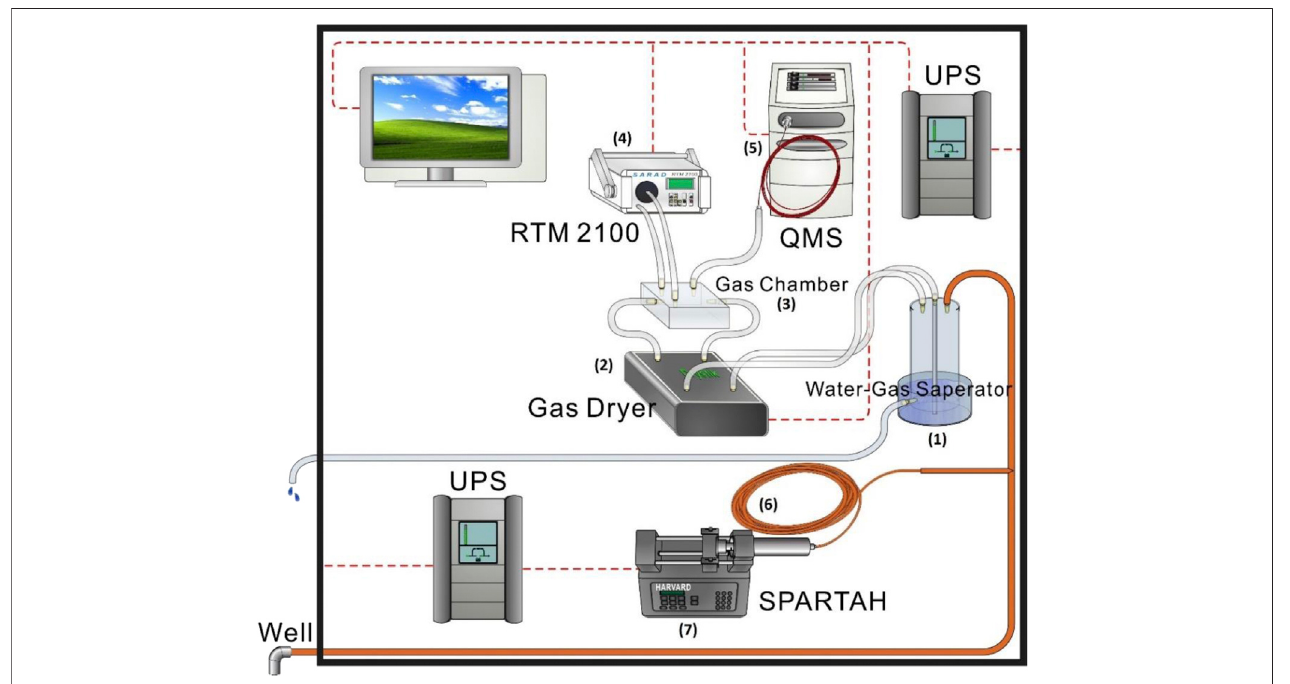
FIGURE 2 | A sketch of the monitoring station, including the dissolved gas analyzer, fl uid collection system, and associated equipment.